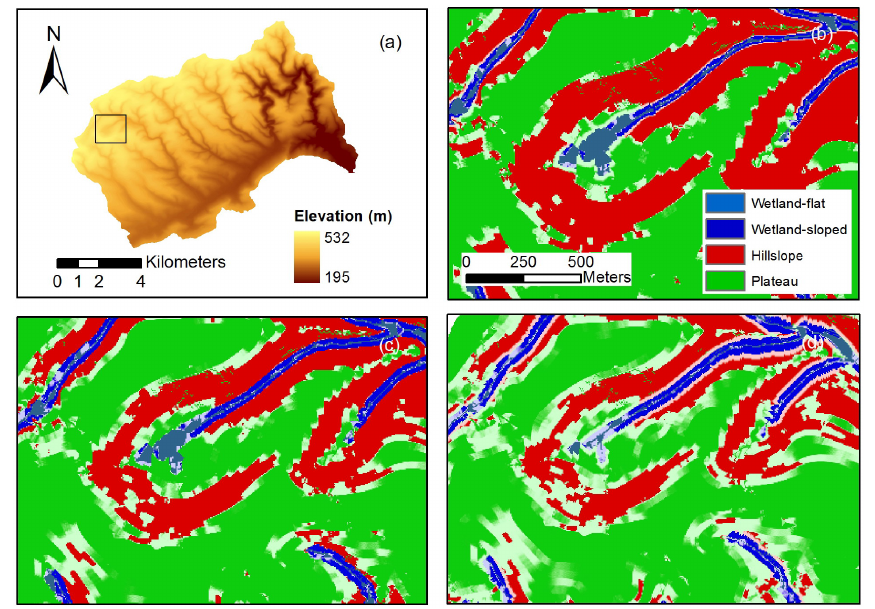
Fig. 4. Comparison between different models for land classification in a headwater of one of the tributaries of the Wark. (a) The location of the headwater in the Wark Catchment; (b) model using HAND and slope ( M SH ); (c) model using distance to the nearest drainage and slope ( M SD ); (d) model using HAND, distance to the nearest drainage and slope ( M SHD ). White areas represent areas which are classified in more than one class with high uncertainty.